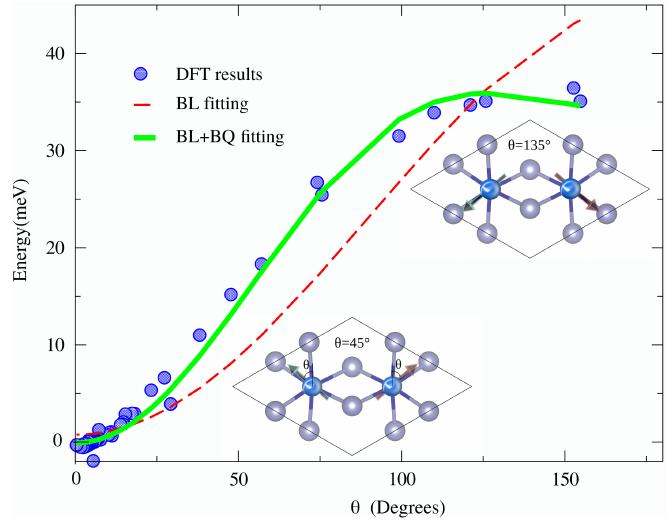
Figure 5. The presence of the higher-order exchange can be capture by performing constrained non-collinear DFT calculations where magnetic moments rotate inplane around the principal axes. Calculated total energy E tot as a function of θ (dots) and different fits using the bilinear Heisenberg and the biquadratic Heisenberg model. The insets show the definition of the spins rotating by angle θ relative to the vertical axis in a unit-cell plane of RuCl 3 and spin configurations at θ = 45 ◦ and 135 ◦